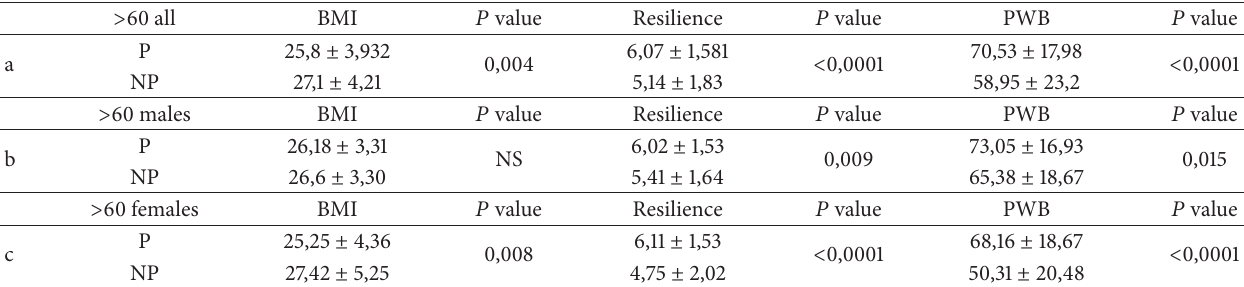
Table 4: Panel a : comparison of BMI, PWB, and resilience between > 60 P and NP. Results are reported as mean ± SD. 𝑃 value has been calculated by Student’s 𝑡 -test between each two groups. Panel b : comparison of BMI, PWB, and resilience between > 60 P and NP Females. Results are reported as mean ± SD. 𝑃 value has been calculated by Student’s 𝑡 -test between each two groups. Panel c : comparison of BMI, PWB, and resilience between > 60 P and NP males. Results are reported as mean ± SD. 𝑃 value has been calculated by Student’s 𝑡 -test between each two groups.